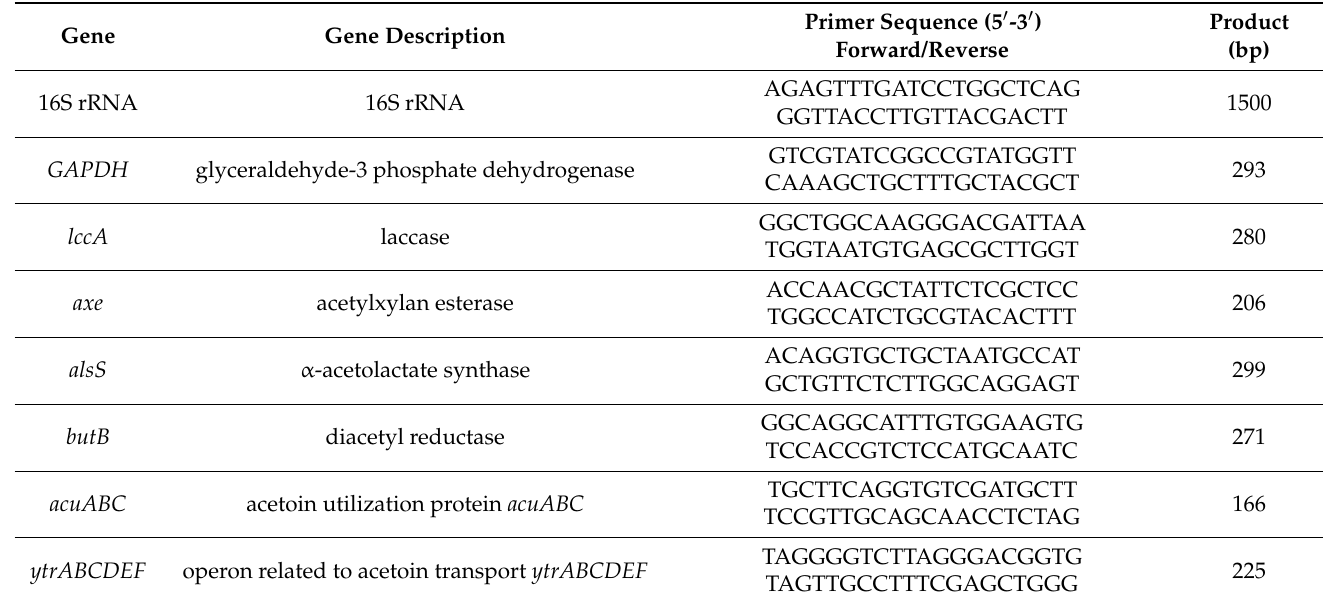
Table 1. Primers for the amplification of 16S rRNA and the relative